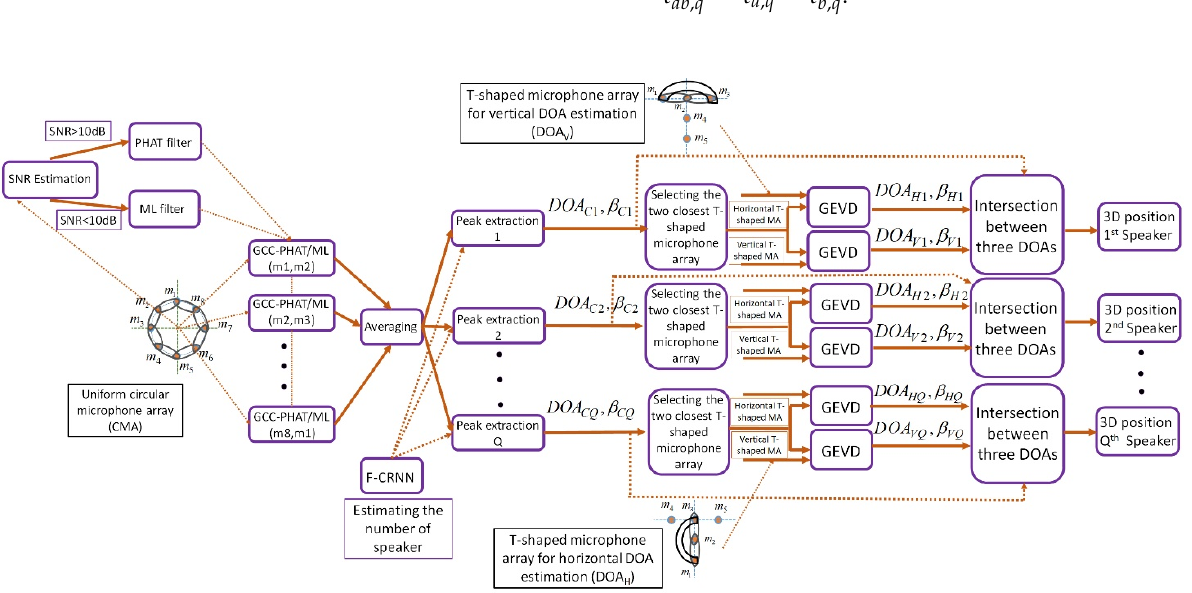
( c ) Figure 2. The proposed structure of T-shaped circular distributed microphone array for SSL, ( a ) central uniform circular array (in combination with GCC-PHAT/ML method), the T-shaped microphone array for ( b ) vertical DOA estimation (DOA V ) (in combination with GEVD method), and ( c ) horizontal DOA estimation (DOA H ) (in combination with GEVD method). 3. The Proposed SSL Algorithm in Combination with Distributed Microphone Array The multiple simultaneous SSL algorithms are divided into one-step and two-step methods. In two-step methods, the time delays are calculated between the microphone pairs and then, the speakers’ directions are estimated based on the microphone array geometry. This category of methods localizes the speakers with low computational